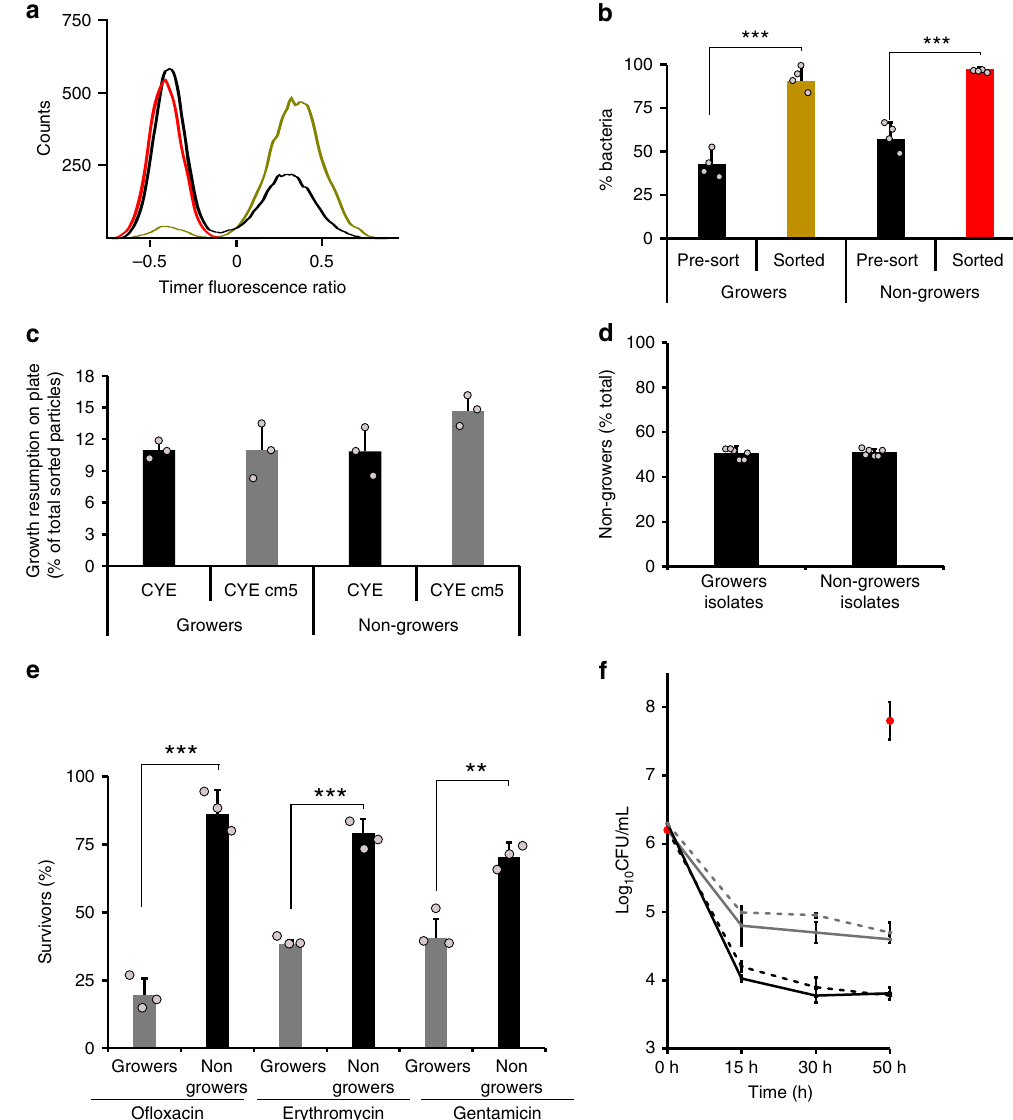
Fig. 2 L. pneumophila intracellular nongrowers are viable and persisters. a , b FACS-sorting of intracellular L. pneumophila subpopulations. A. castellanii were infected with L. pneumophila /Timer (MOI 1, 24 h) and lysed. Released intracellular bacteria were FACS-sorted according to their Timer green/red color ratio, sorted subpopulations were reanalyzed by fl ow cytometry and compared with the initial infected cell lysate (pre-sort) to evaluate the separation ef fi ciency. a Graph, (representative for four biological replicates) and b the quanti fi cation is shown. Pre-sort, black; growers, yellow; nongrowers, red. c Intracellular growers and nongrowers resume growth on CYE plates. To determine re-growth, FACS-sorted intracellular growing and nongrowing L. pneumophila /Timer subpopulations were plated on CYE or CYE/Cam plates and CFU were determined (plating ef fi ciency: CFU*100/sorted fl uorescent particles). d Growth rate heterogeneity is a reversible phenotypic trait. FACS-sorted intracellular growing and nongrowing L. pneumophila